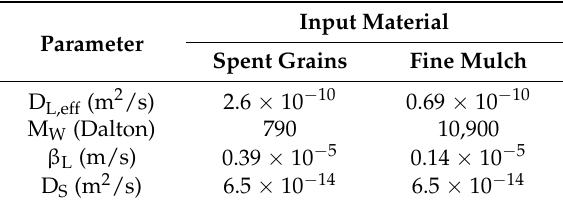
Figure 3. Overall isotherms of pre-treated HTC fine mulch PW and fit of the IAST model. The effective diffusivities D L,eff derived from short fixed-bed column tests are given in Table 4. They differ by a factor of 3.8, indicating a significant difference in molecular size. This is illustrated